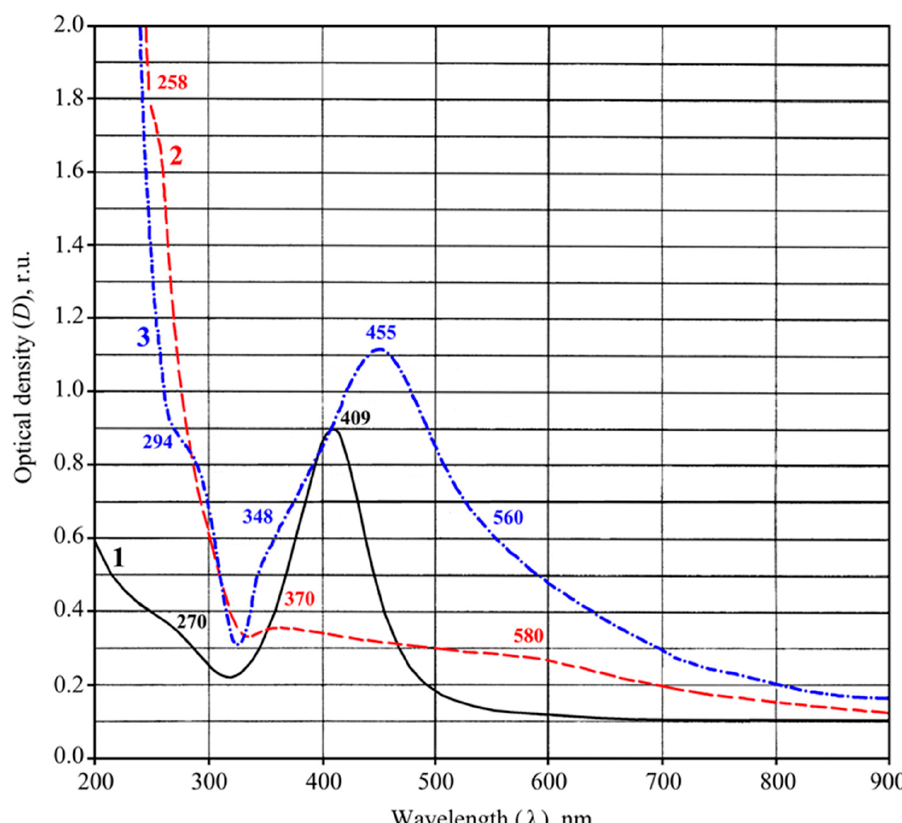
Figure 1. UV–Vis absorption spectra of the daylight-exposed aqueous solutions of PAAg: for one hour (black solid line 1), PAAg stored in solid state for one year (red dashed line 2), and PAAg stored as aqueous solution for one year (blue dashed line 3). In the second case, optical density was intentionally increased to show two less evident maxima of optical absorption at 370 and 580 nm.